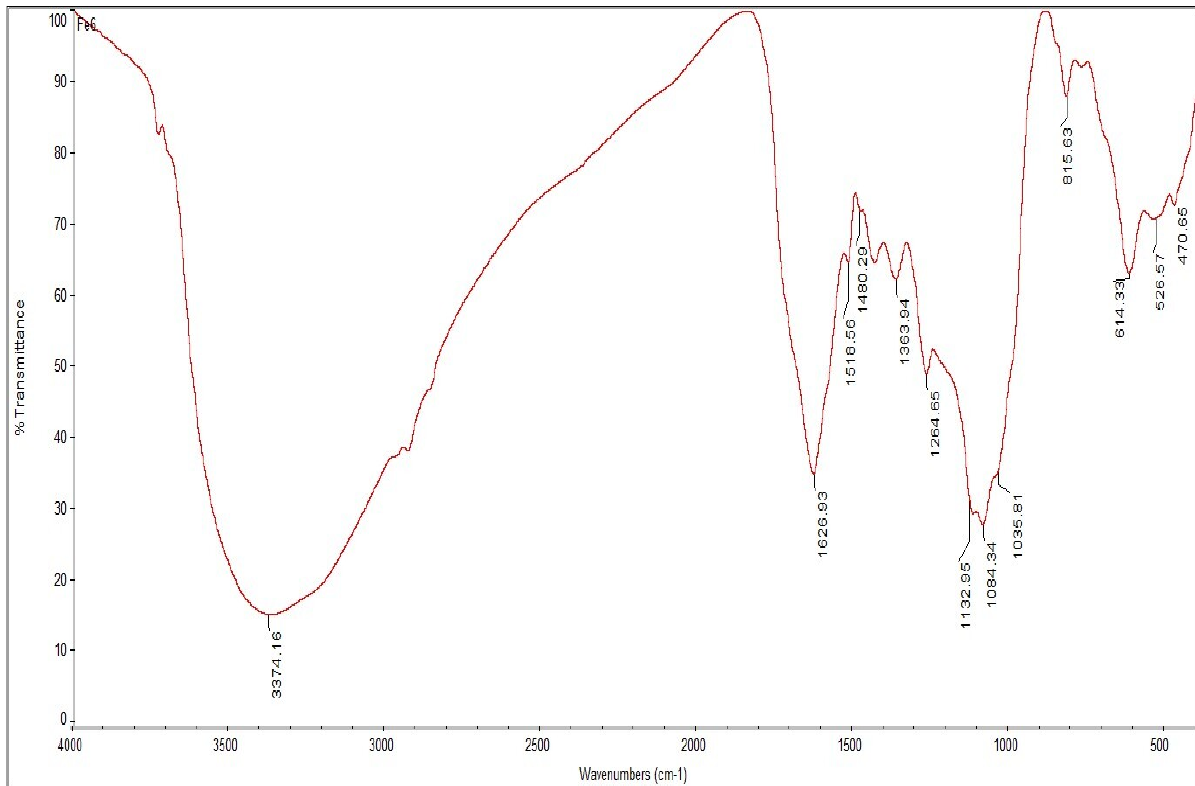
Figure 4. FTIR spectra showing the peaks of FeNPs synthesized from V. leucoxylon.